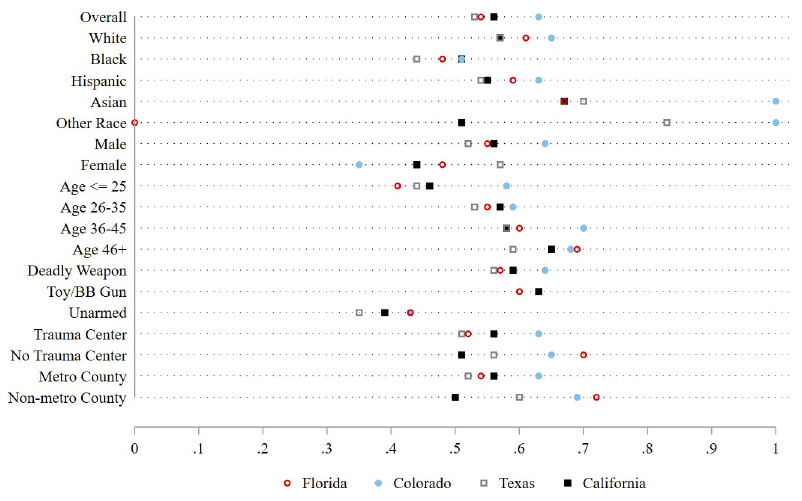
Fig 3. Proportion of shootings that were fatal across each covariate, in each state.